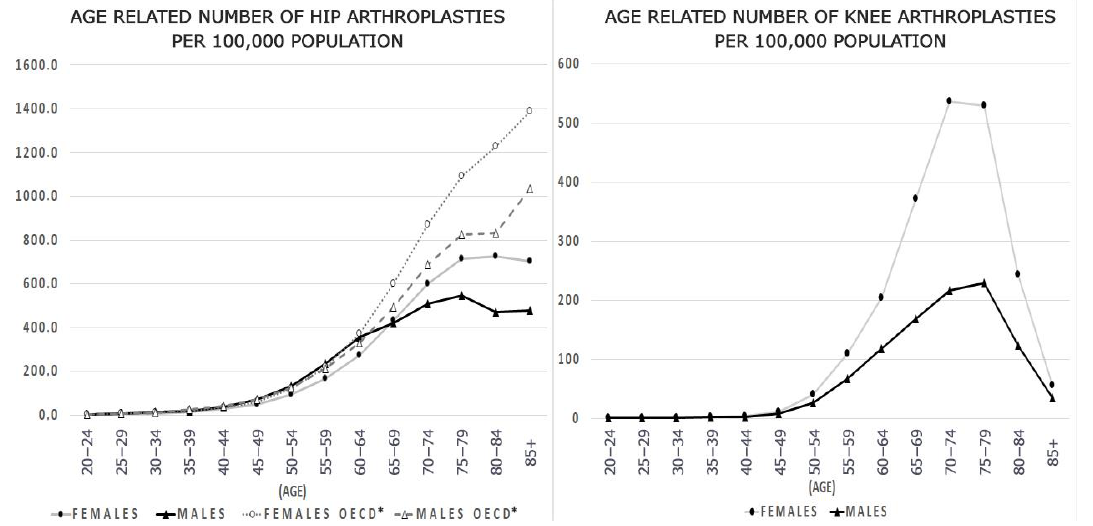
Figure 1. Number of hip and knee replacement procedures per 100,000 people in Poland and OECD. * OECD data-2008 or latest year